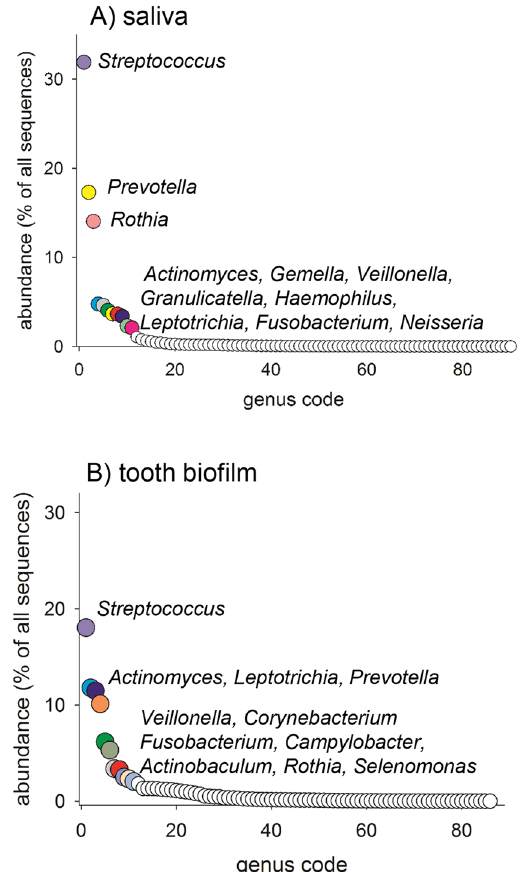
Figure 1. Abundance plot of genera in ( A ) saliva and ( B ) tooth